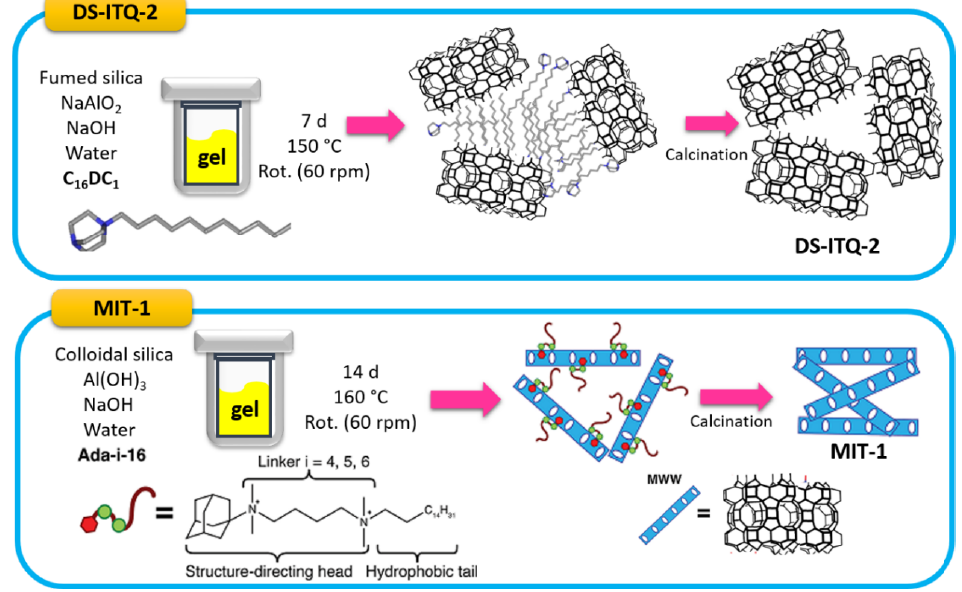
Figure 8. Representation of the syntheses of DS-ITQ-2 and MIT-1.